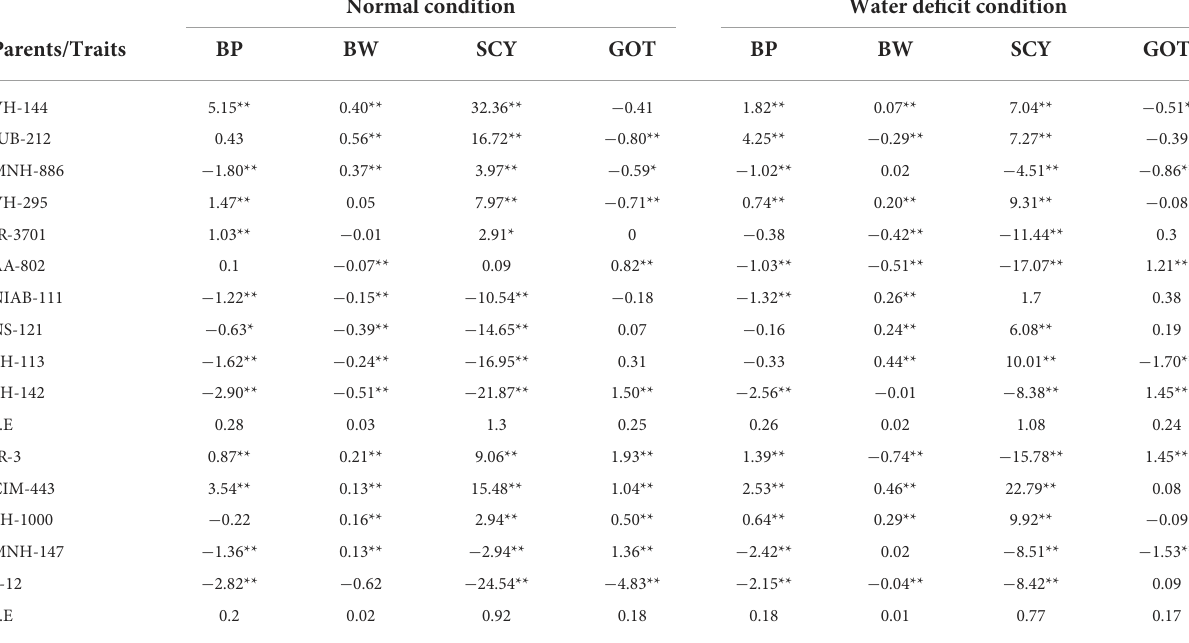
TABLE 4 Estimation of general combining ability effects for various yield-related traits under normal and water deficit condition. Normal condition Water deficit